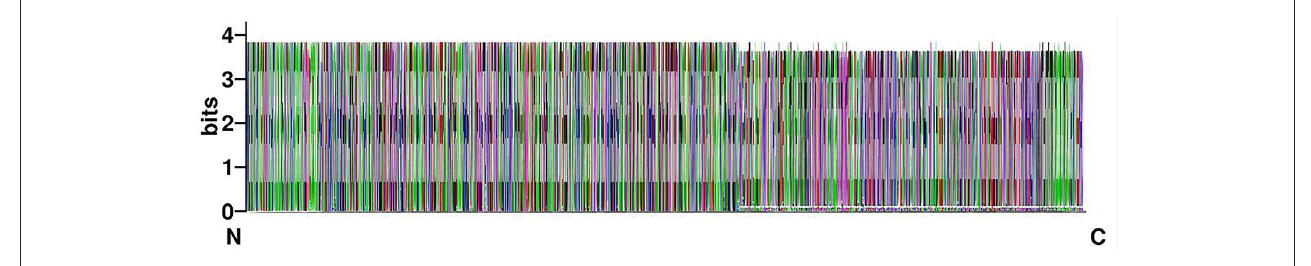
FIGURE2 Results of SADS CoV full length S protein conservation